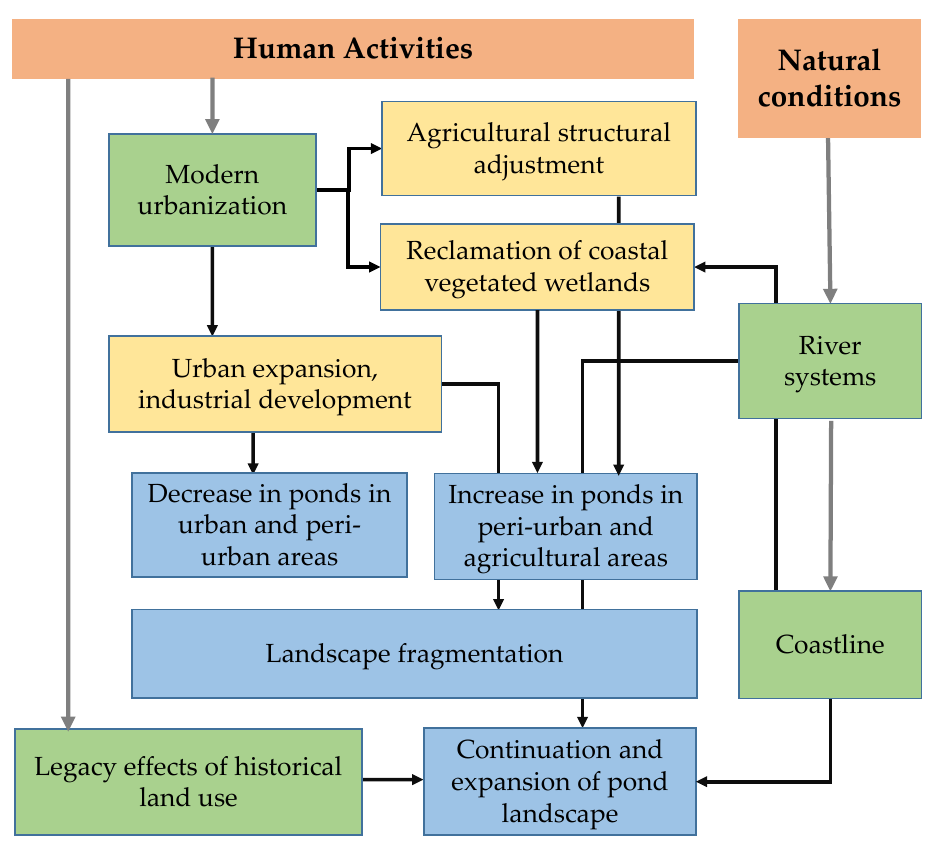
Figure 9. Influence of human activities and natural conditions on the spatial heterogeneity of the pond landscape across an urban-rural gradient in the PRD.